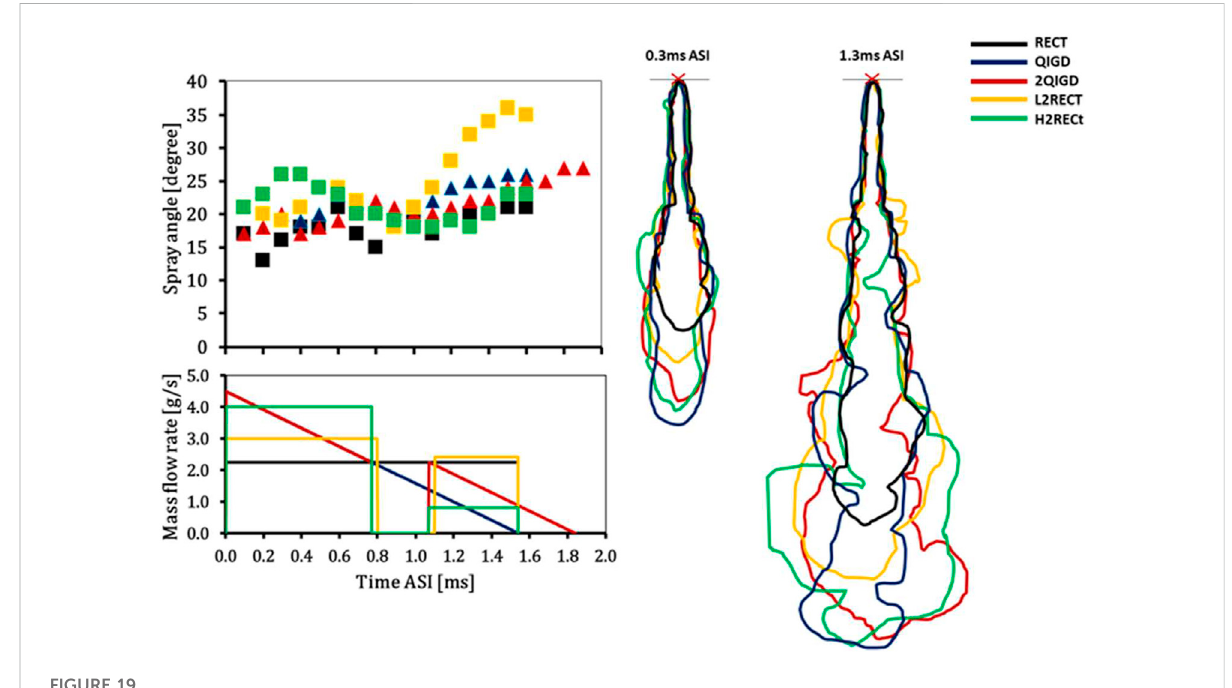
FIGURE 19 Comparison of spray angle of different injection